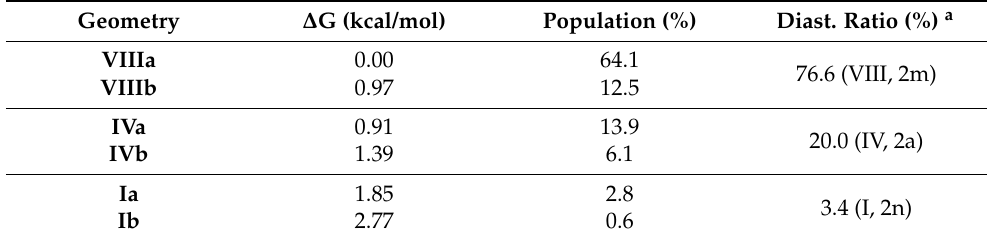
Table 3. Populations (%) of the most stable geometries for systems I – VIII , obtained from the relative free energies ( ∆ G, 25 ◦ C) and the Boltzmann distribution law.